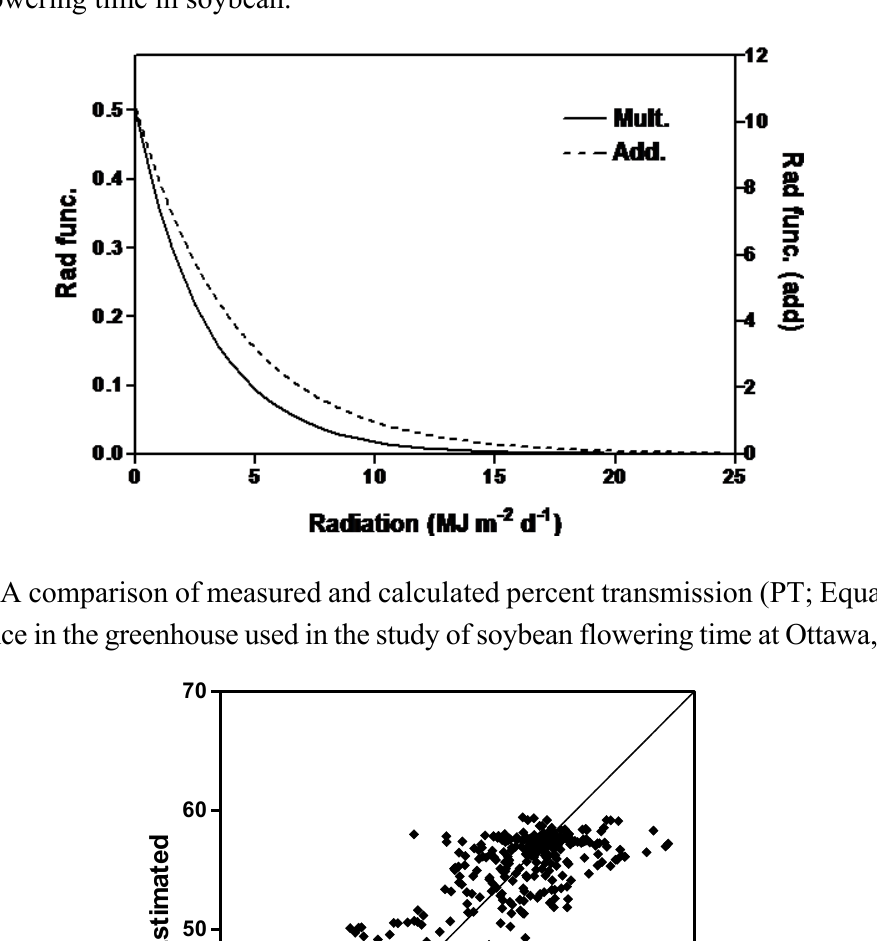
Figure 3. The solar irradiance functions for the multiplicative and additive models which predict flowering time in soybean.